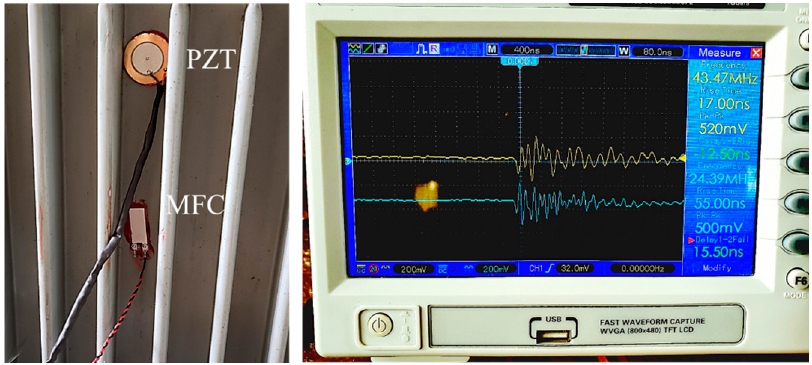
Figure 4. AE sensors coupled with the transformer’s walls and PD signals captured by an oscilloscope.